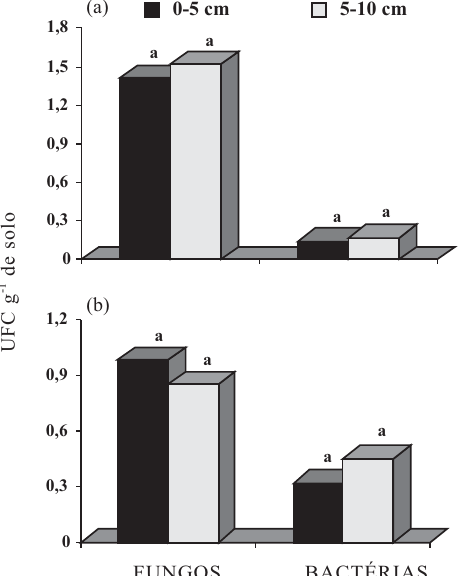
Figura 3. Distribuição da população de fungos e bactérias (UFC), em diferentes profundidades, no período 1 (a): outubro/2003 a setembro/2004 e, no período 2 (b): outubro/2004 a